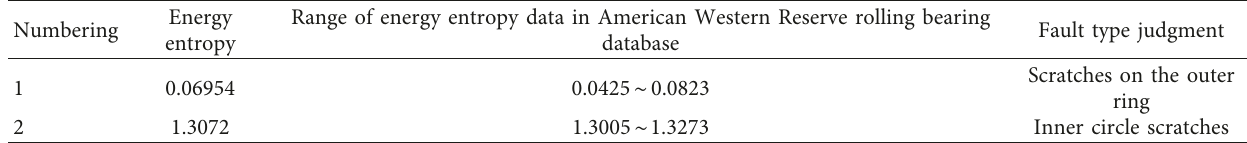
Table 2: Failure type database comparison